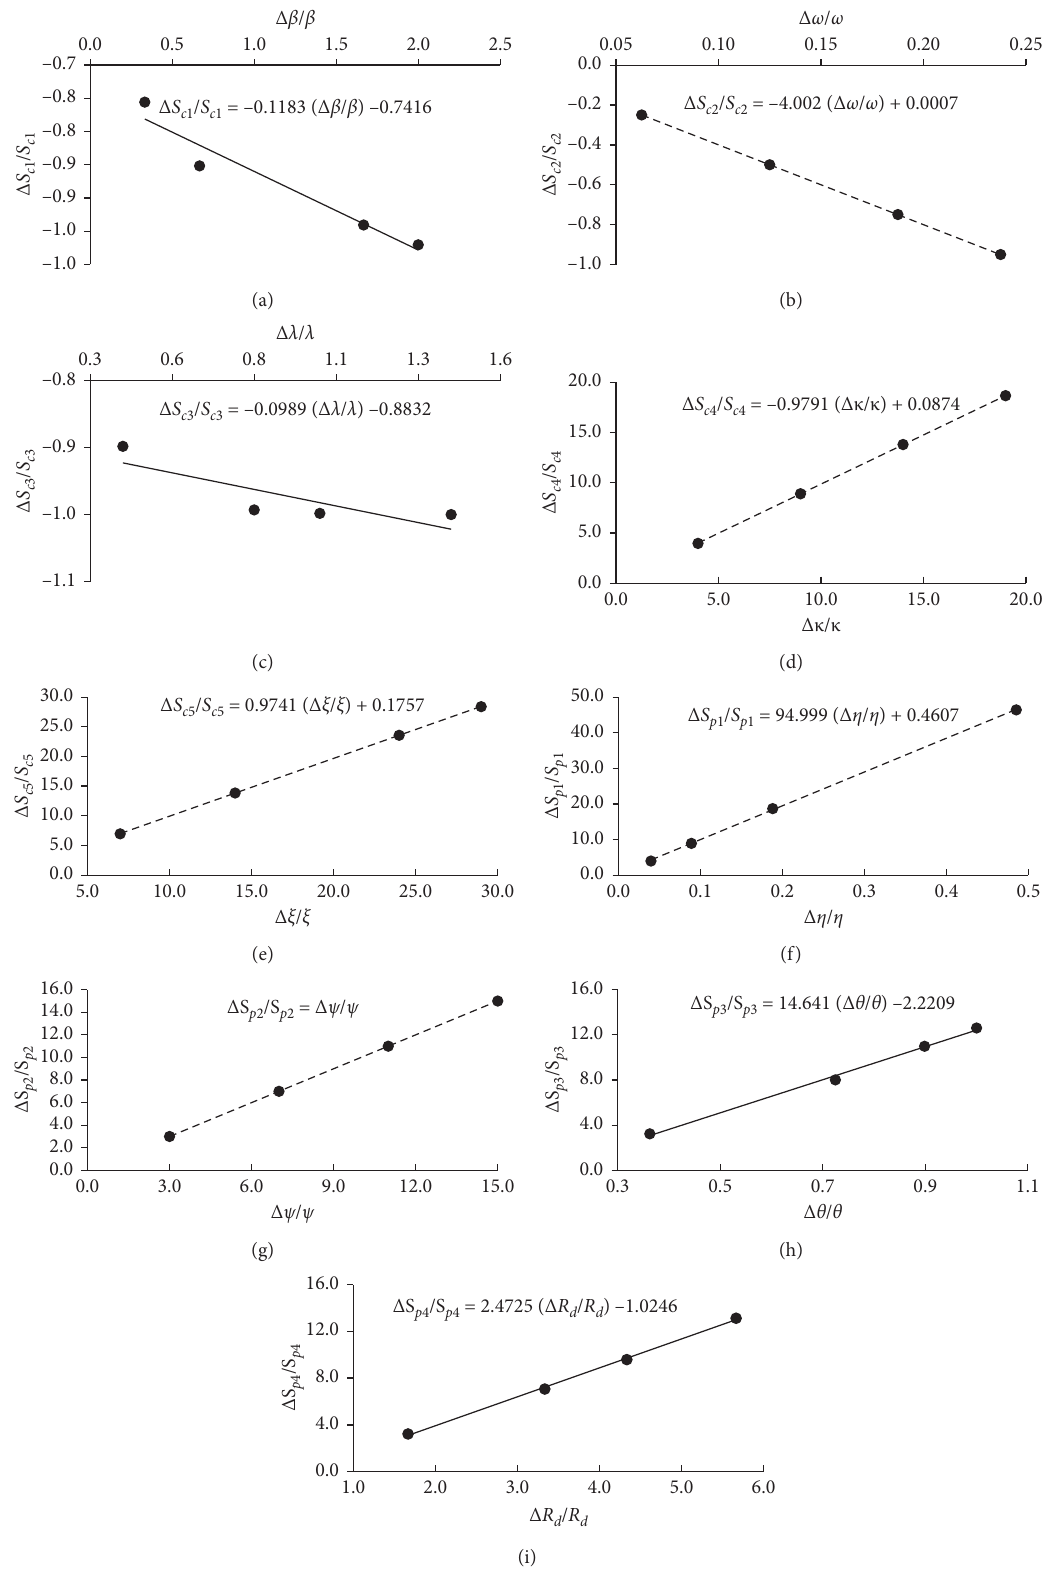
Figure 8: RelationshipbetweentheMSSratioandtheinfluencingfactorratios:(a) Δ S S c 4 − Δ κ / κ , (e) Δ S c 5 / S c 5 − Δ ξ/ξ , (f) Δ S p 1 / S p 1 − Δ η/η , (g) Δ S p 2 / S p 2 − Δ ψ / ψ , Δ S p 3 / S p 3 − Δ θ / θ , and (i) S p 4 / S p 4 − Δ R d / R d